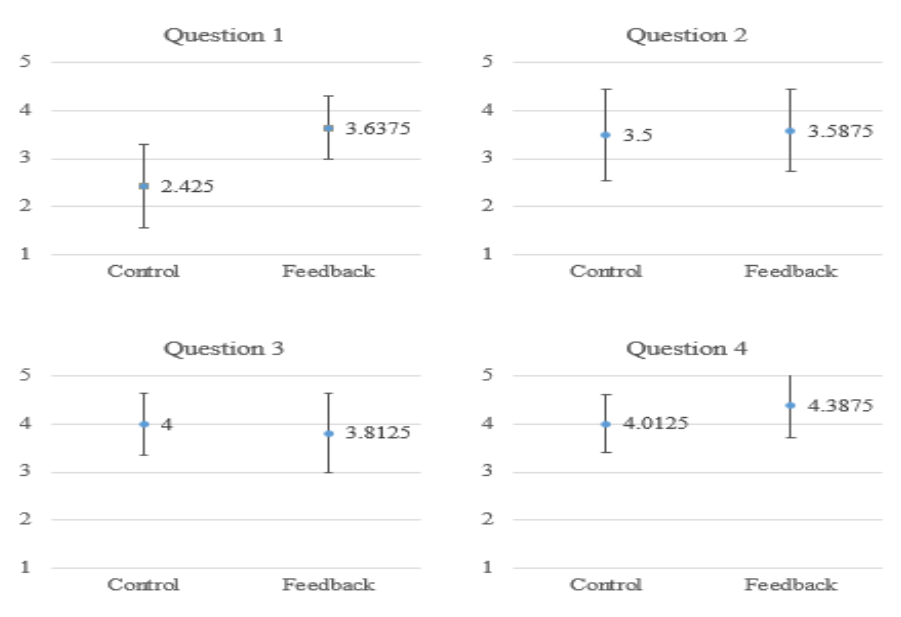
Figure 13. The average count per minute of eye blinking events from first to the 19th minute.